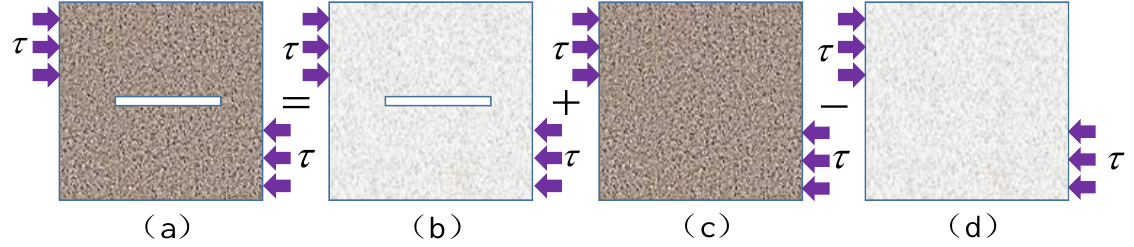
Figure 4. ( a ) Joint sample damaged by freeze-thaw and shear coupling, ( b ) joint sample with shear damage, ( c ) intact rock samples with freeze-thaw damage, ( d ) intact rock sample with shear damage. Calculation method for the equivalent strain of jointed rock specimens.